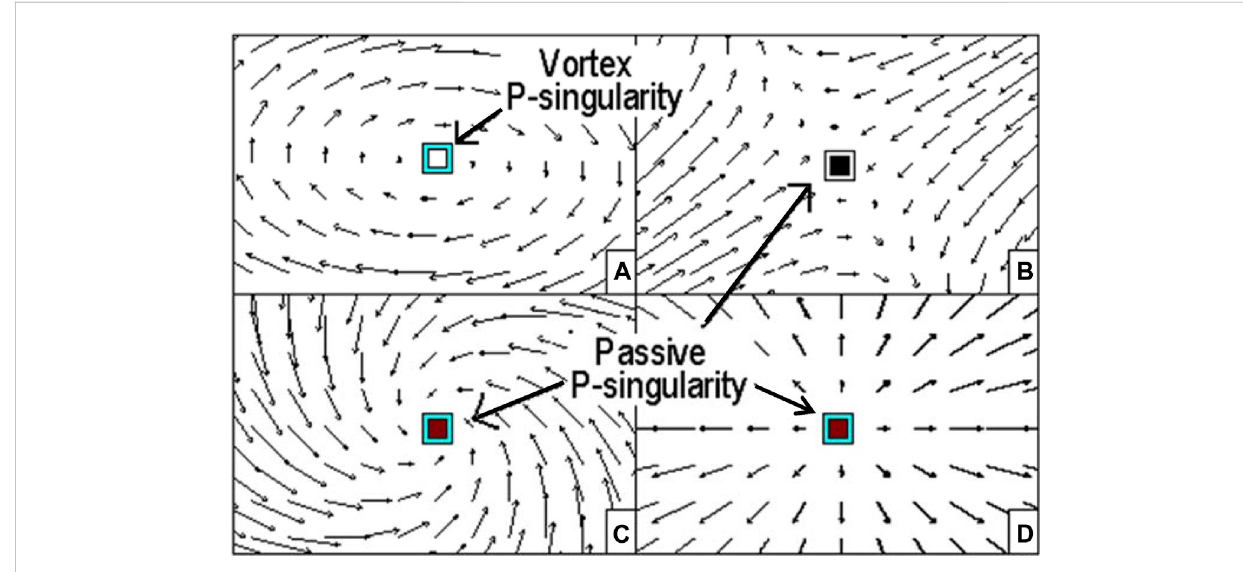
FIGURE 12 Behavior of the transverse Poynting vector component near the P -singularity: (A) vortex-type singularity, (B) saddle, (C) attractive focus, (D) source; (B – D) represent passive singularities.